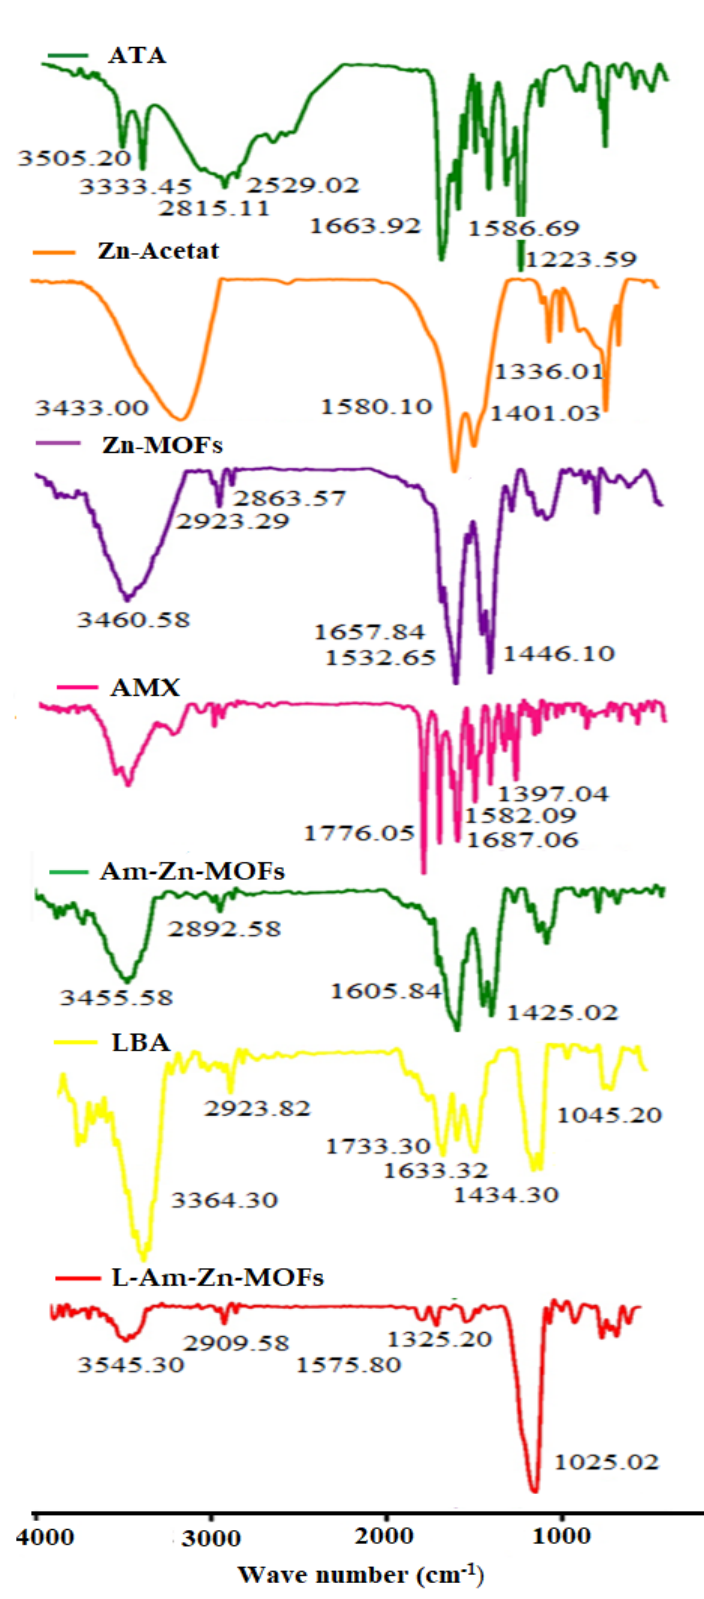
Figure 1. FTIR Spectrum of ATA, Zn-Acetate, Zn-MOFs, AMX, Am-ZnMOFs, and L-Am-Zn-MOFs.